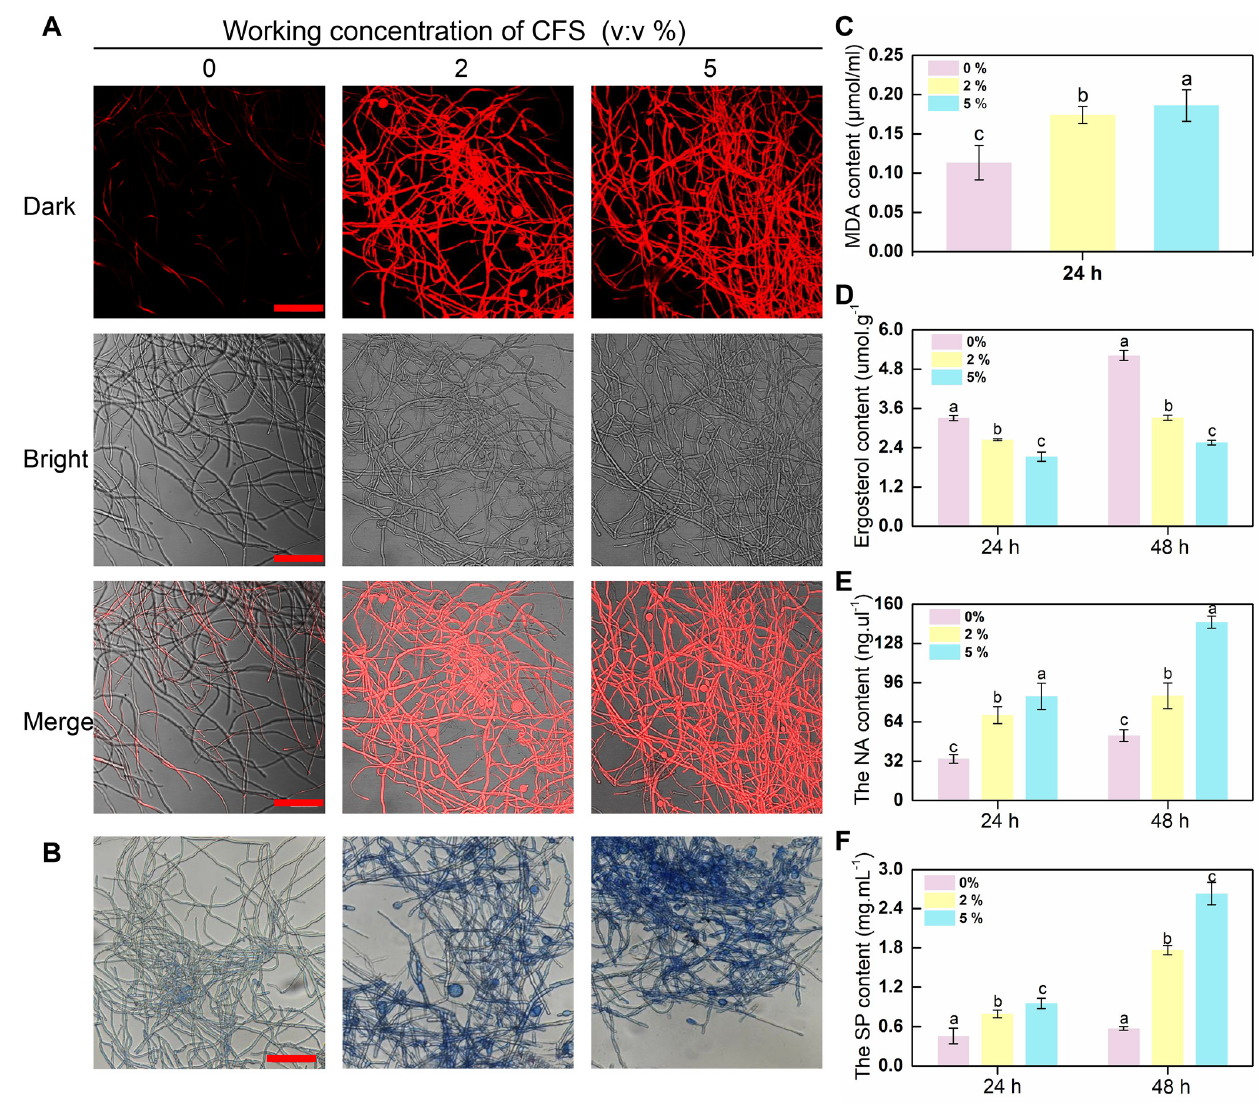
Figure 3. Injury efficacy of CFS on the hyphal cytomembrane of B. dothidea . ( A ) Detecting the integrity of the membrane of hyphal cells stained by propidium iodide (PI). The fluorescence signal was detected using a laser scanning confocal microscope at 405 nm excitation and 633 nm emission. (B) Detecting the integrity of membrane and activity of hyphal cells at 24 h after the application of CFS stained by trypan blue. The images were recorded using a microscope. The red bars represent 50 µm. ( C , D ) The content of MDA and ergosterol in hyphae after treatment with CFS for 24 h and 48 h. ( E , F ) Nucleic acid (NA) and Soluble protein (SP) contents were measured in a hyphal culture medium after different amounts of CFS t reatment at indicated period. Vertical bars represent standard deviations of the means. Columns followed by different letters are statistically different by the Duncan’s multiple ranges ( p < 0.05).